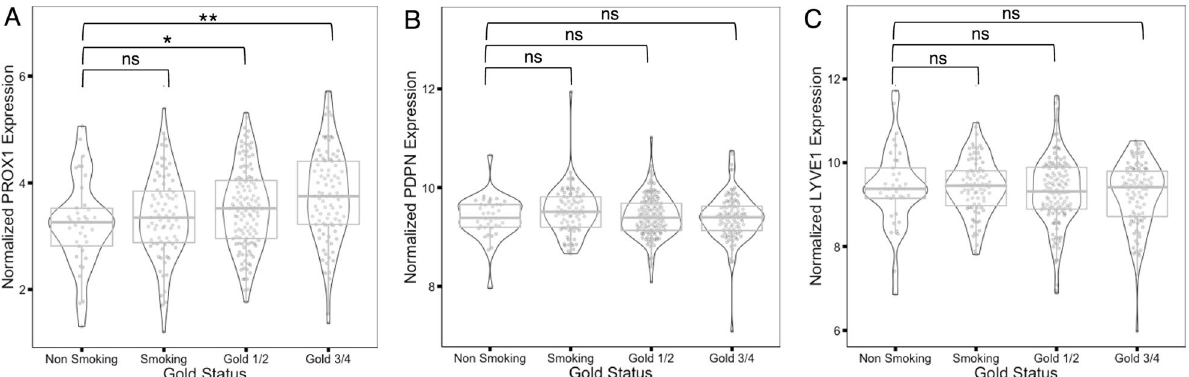
Figure 1. Expression of lymphatic endothelial cell markers in human COPD lung tissue . In silico analyses of microarray datasets from the LTRC tissue consortium for PROX1 ( A ) Podoplanin ( PDPN , B ), and LYVE1 ( C ) in lung tissue from nonsmoker control, smoker control, GOLD1/2 (mild COPD), and GOLD3/4 (severe COPD) lungs. *P < 0.05, **P <